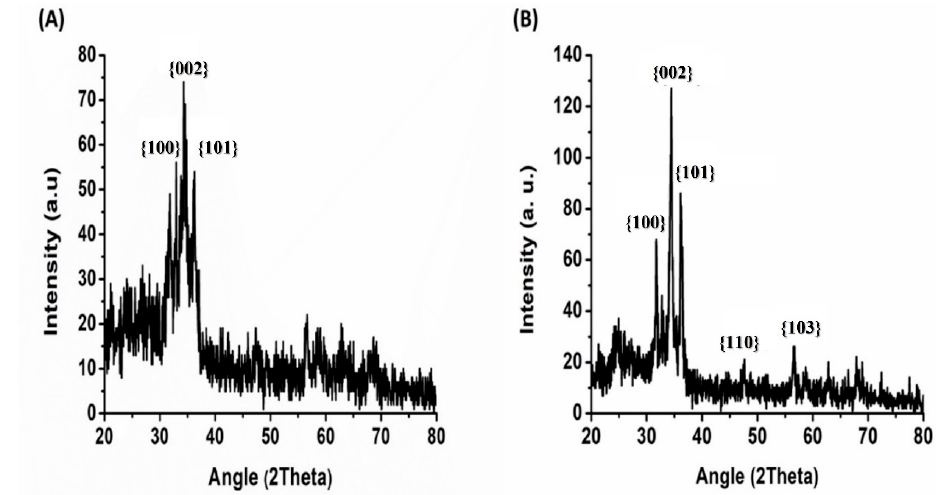
Figure 4. XRD patterns of AZO for ( A ) thick film and ( B ) disk type samples used in this work.